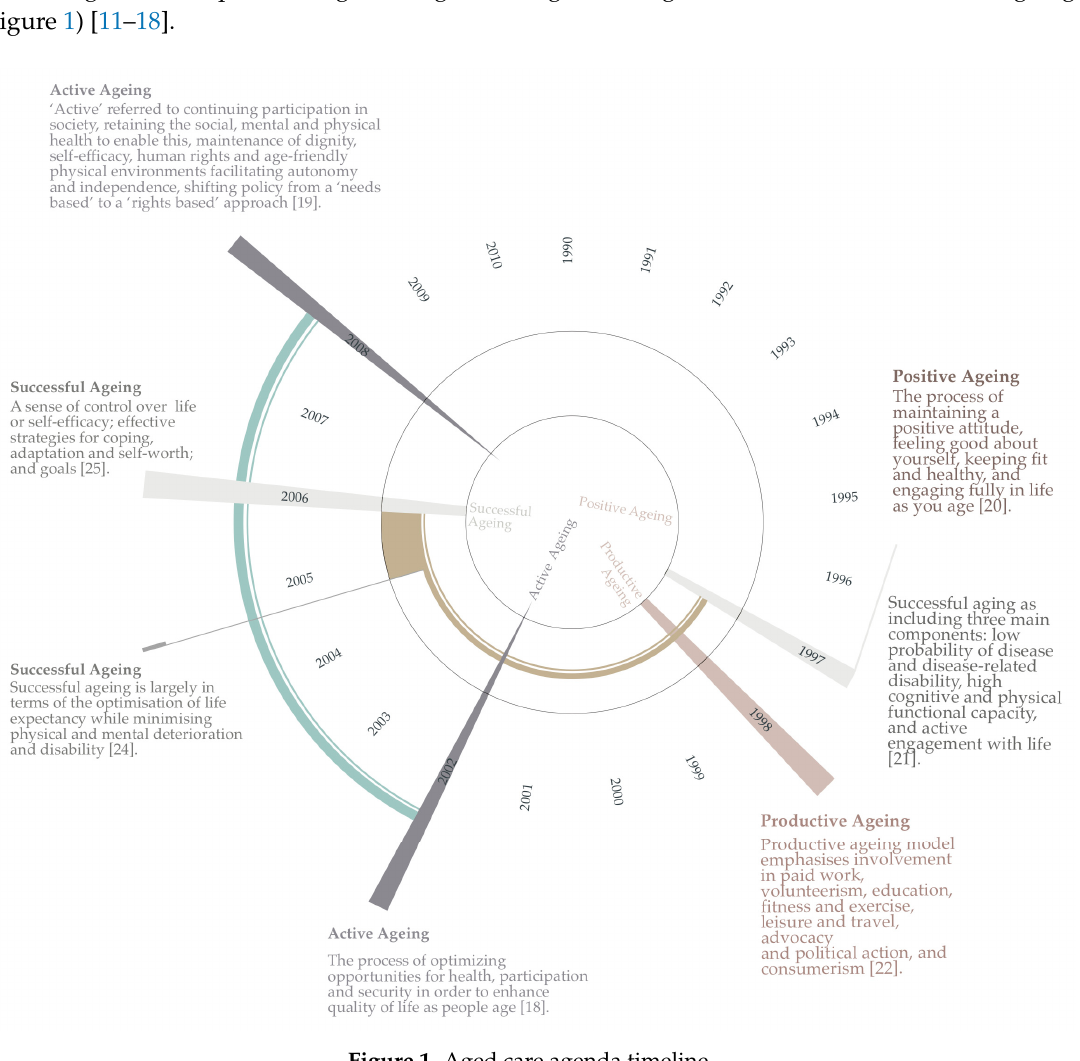
Figure 1. Aged care agenda timeline.